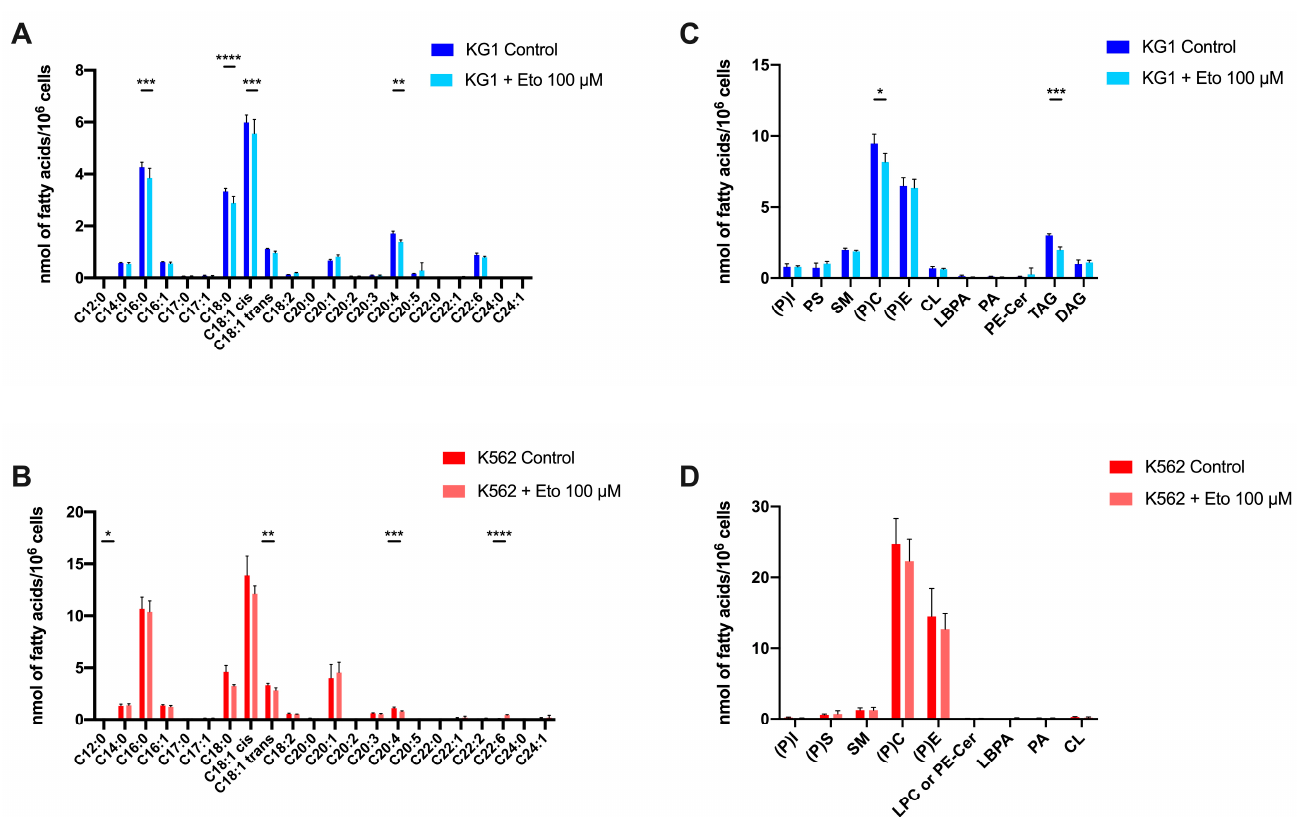
Figure 4. Impact of a low dose of etomoxir on the two cell lines KG1 and K562. ( A , B ) Composition of total fatty acids in KG1 and K562, respectively, at basal state versus with 100 μ M etomoxir. ( C , D ) Lipid species quantification in KG1 and K562, respectively, at basal state versus with 100 μ M etomoxir. * p < 0.05, ** p < 0.01, *** p < 0.001, **** p < 0.0001.